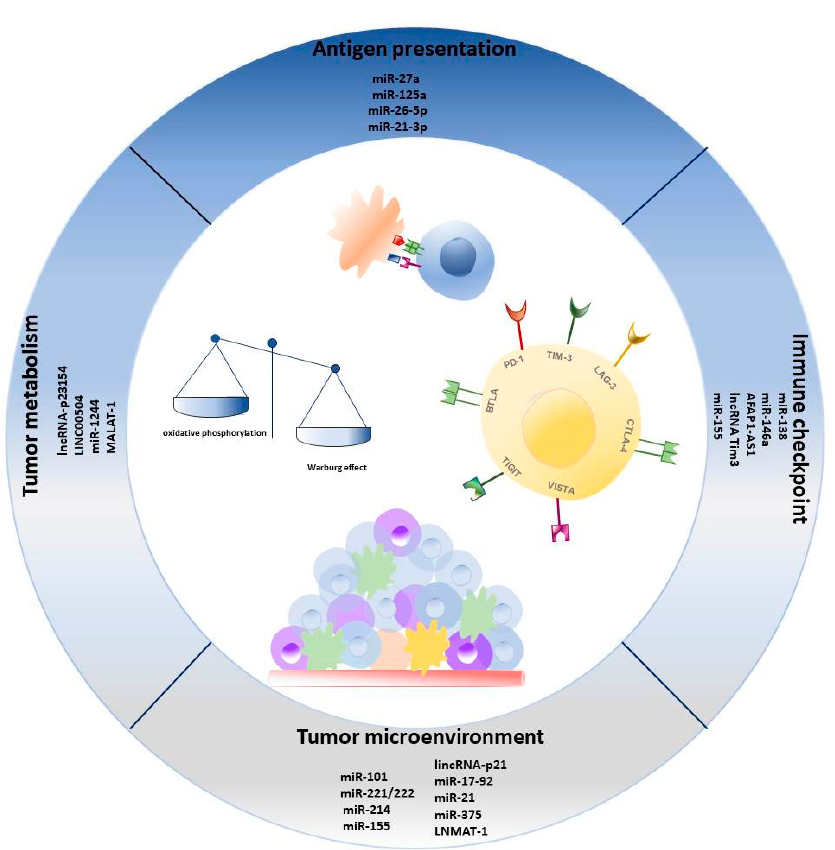
Figure 1. Overview of most relevant ncRNAs involved in cancer immune regulation of antigen presentation, tumor metabolism, immune checkpoint expression, and microenvironment compo- sition.